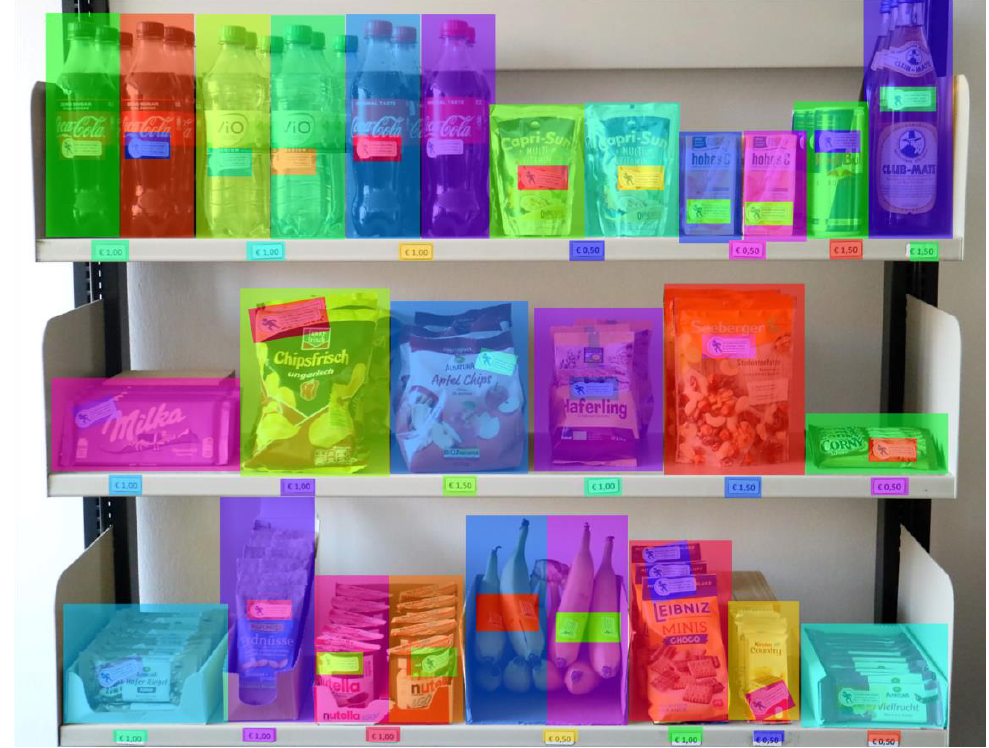
Figure 3. Static AOIs covering the PACE on every product and the price signs in front of the prod- ucts.